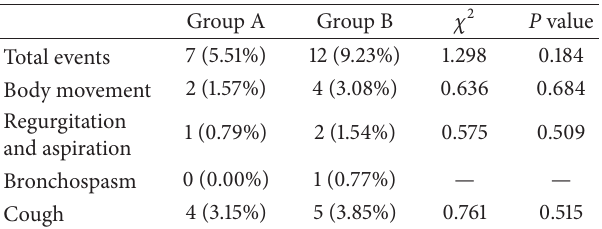
Table 5: Adverse events in Group A and Group B, 𝑛